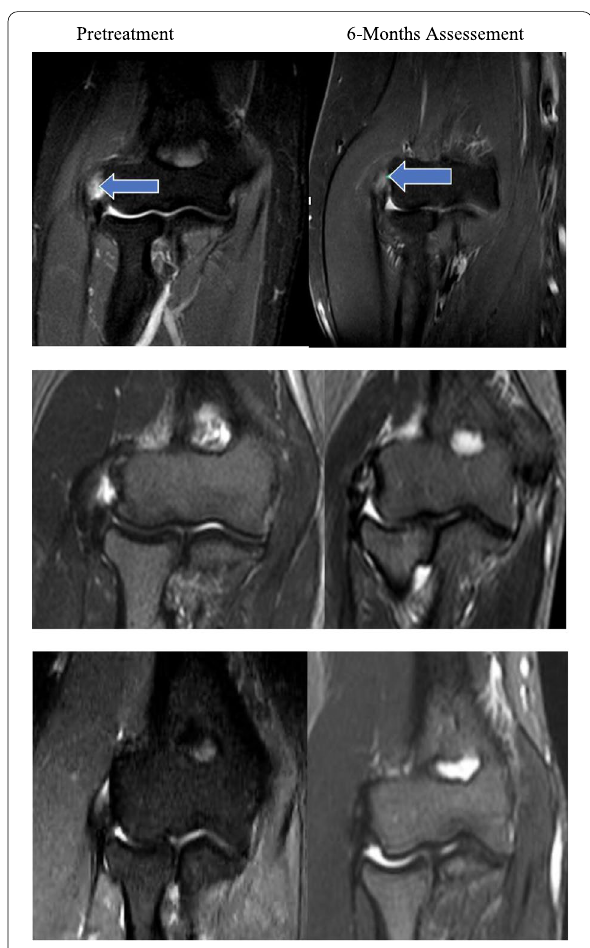
Fig. 2 STIR Magnetic resonance imaging (MRI) results after autologous adipose derived stromal cells injection. Top row: patient 2´s score was 4 (tendinopathy [TD], 2; tear, 2) at pretreatment, and 3 (TD, 2; tear, 1) at 6 months assessement. Middle row: Patient 8´s score was 6 (TD, 3; tear, 3) at pretreatment, and 3 (TD, 2; tear, 1) at 6 months